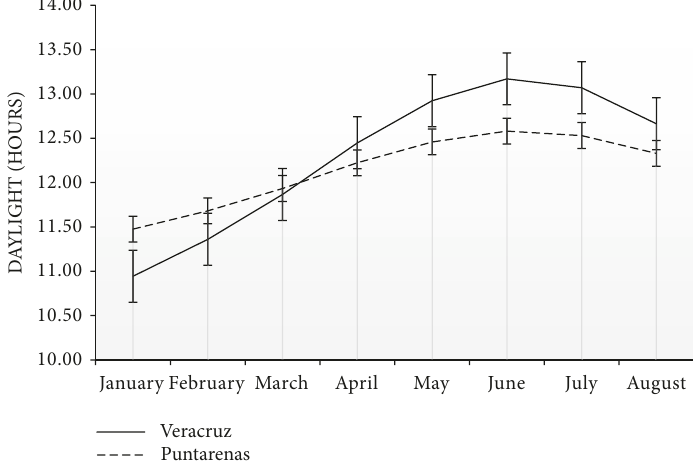
0.150.170.190.210.230.250.270.29